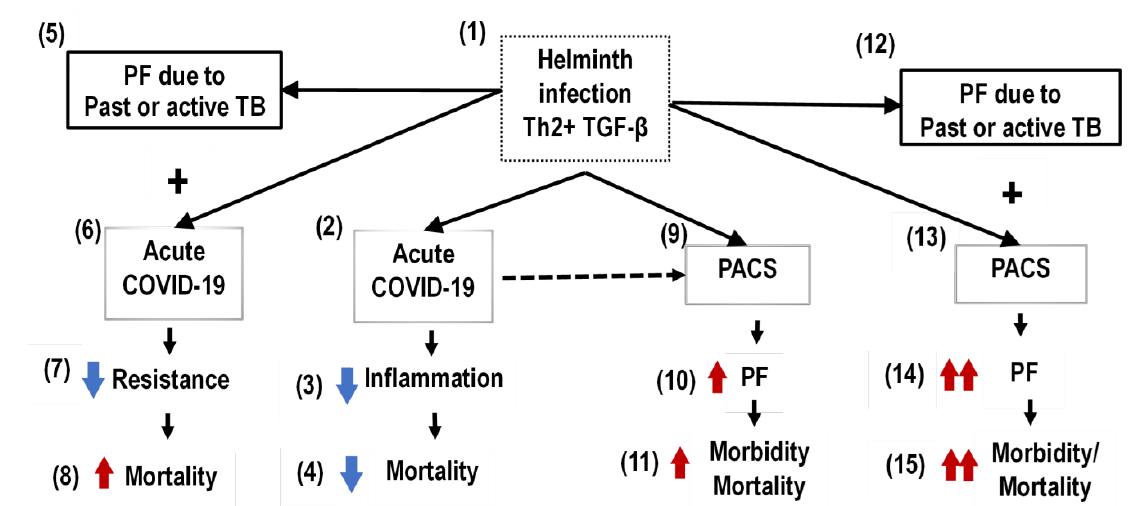
Figure 1. Overlapping of acute COVID-19 and postacute COVID-19 syndrome (PACS) and tuberculosis (TB) in the helminth coinfection setting in sub-Saharan Africa (SSA) population. (1) Helminth coinfection inhibits inflammation and amplifies pulmonary fibrosis (PF) processes; (2 – 4) helminth coinfection inhibits COVID-19 lung inflammation and decreases mortality; (5 – 8) infection by Mycobacterium tuberculosis and PF due to past or active TB limit resistance to COVID-19 and increase mortality; (9 – 11) PACS, amplified by helminth infection, increases morbidity and mortality; (12 – 15) the overlapping of PF due to past or active TB with PF due to PACS, amplified by helminth infection, increases morbidity and mortality.